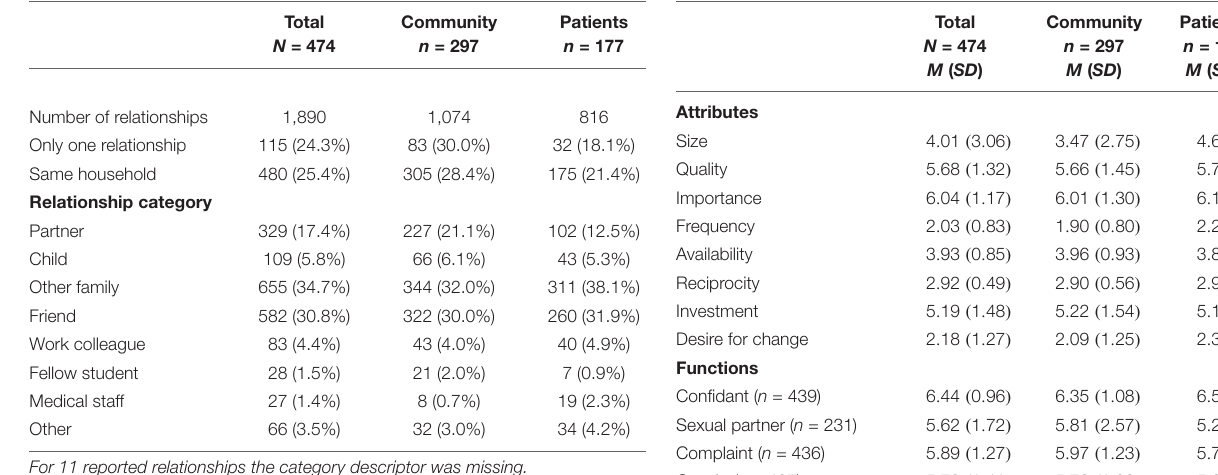
TABLE 2 | Distribution of reported relationship by category for the overall, community, and patients sample.